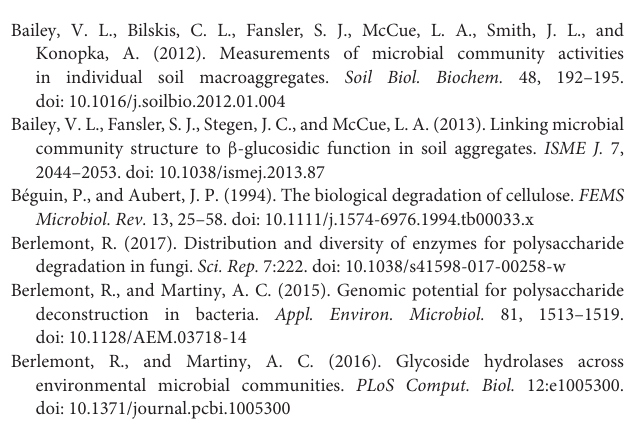
Supplementary Figure 1 | NMDS of 16S rRNA genes from corn (C), unfertilized prairie (P), and fertilized prairie (FP) metagenomes.